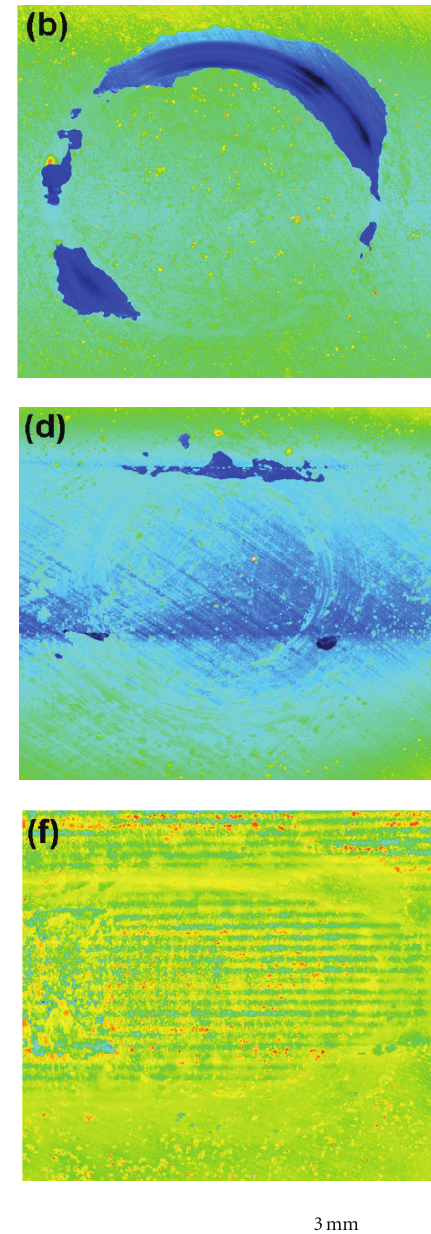
Figure 12: Wear patterns of diamond coated WC-Co substrate: (a) 800 W, (b) 900 W, (c) 1000 W, (d) 1100 W, (e) 1200 W, (f) 1300 W. substrate surface roughening is a crucial issue a ff ecting diamond film adhesion [8, 34,